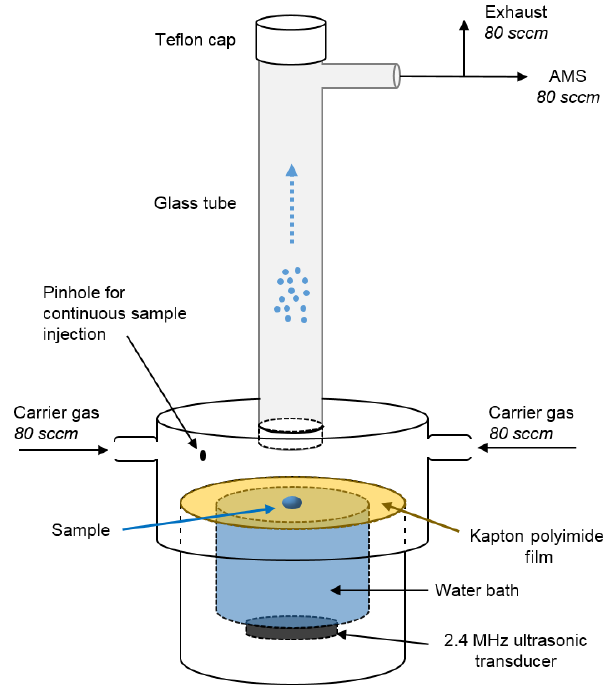
Figure 1. Schematic diagram of the small-volume ultrasonic nebu- lizer (SVN). Samples (2–4µL) are loaded on the Kapton (or Teflon) film through either the hole in which the glass tube is seated (for dis- crete injections) or through the pinhole (for continuous injections). After the transducer is turned on, the aerosol is carried up through the glass tube and into the instrument by a ∼ 160sccm (standard cubic centimeters per minute) flow of zero air or argon carrier gas. The water bath between the transducer and the Kapton film carries ultrasonic waves up to the film and serves to cool the ultrasonic